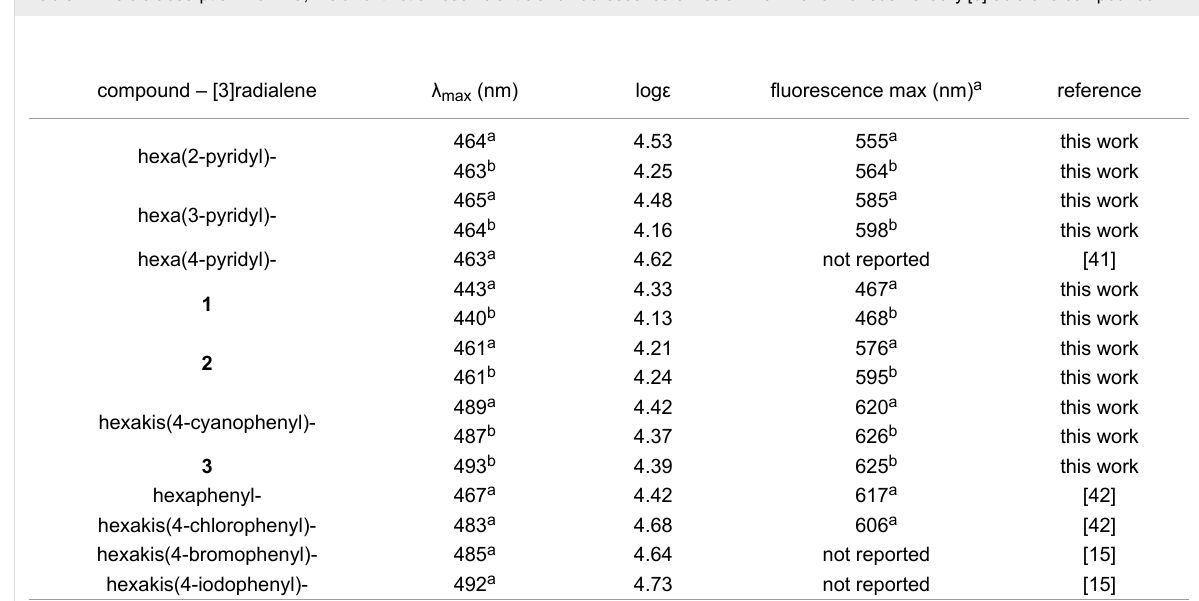
Table 2: Visible absorption maxima, molar extinction coefficient ε and fluorescence emission maxima for various hexaaryl[3]radialene compounds.